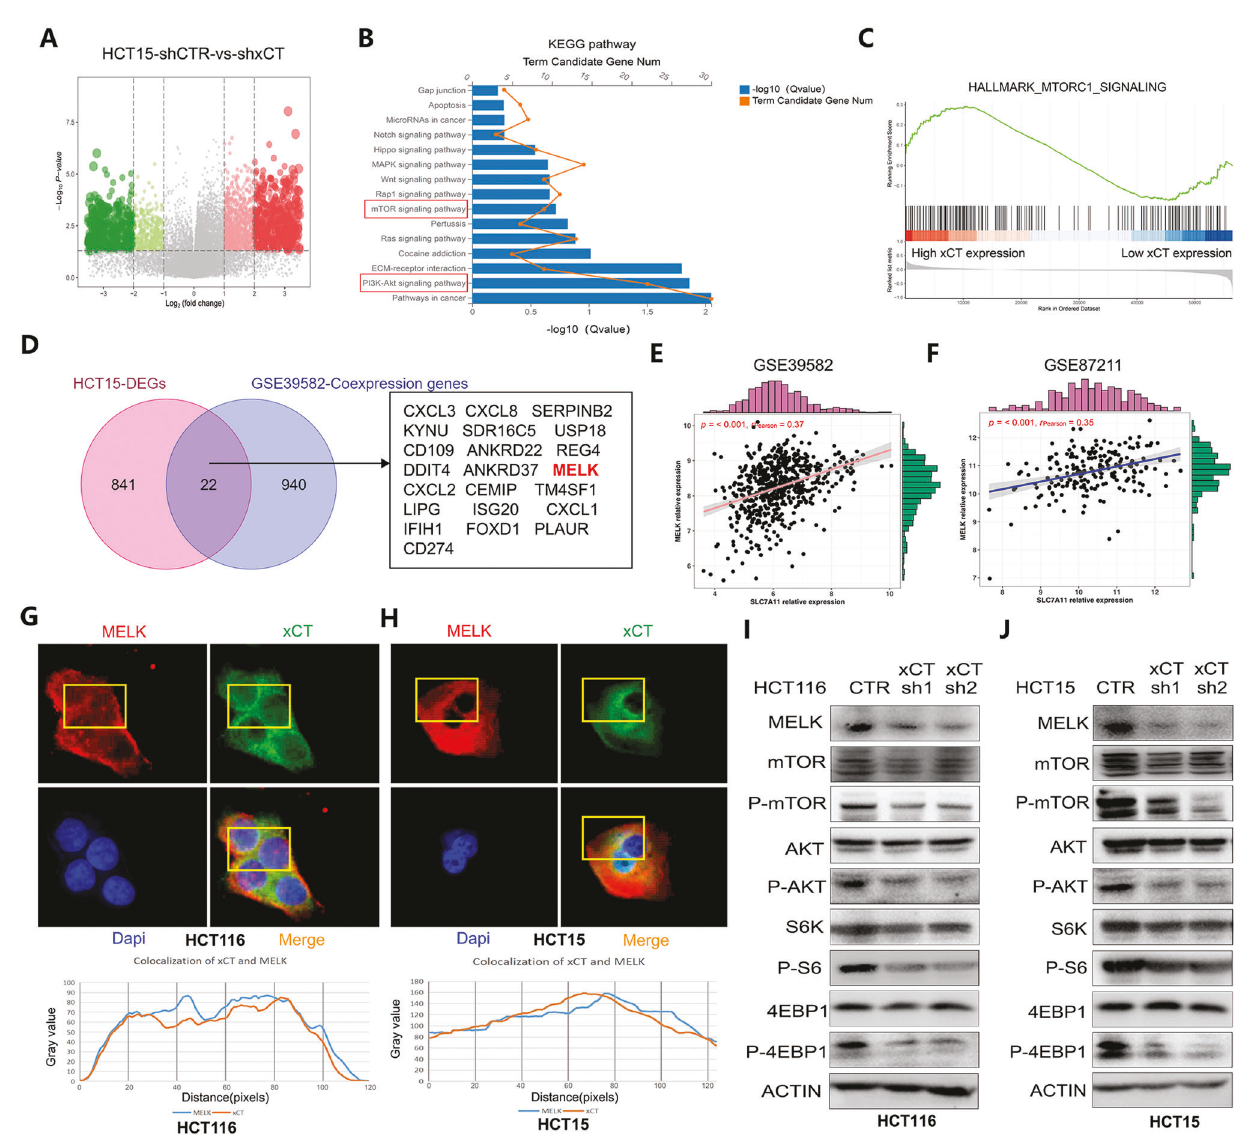
Fig. 7 xCT activates the AKT/mTOR signaling pathway and enhances MELK expression in CRC cells. A DEGs in HCT15 cells with or without xCT shRNA administration. B KEGG analysis was performed on the DEGs. C GSEA showed that xCT was upregulated in samples with the activation of the hallmark_mTORC1_signaling pathway. D Identi fi cation of potential factors whose expression might correlate with that of xCT in CRC. E , F The correlation between the expression of MELK and xCT in GSE39582 and GSE87211. G , H IF assays con fi rmed that MELK and xCT were strongly colocalized in HCT116 and HCT15 cells. I , J Western blot analysis showed that xCT knockdown inhibited the expression level of MELK and restrained the activation of the AKT/mTOR signaling pathway in HCT116 and HCT15 cells.